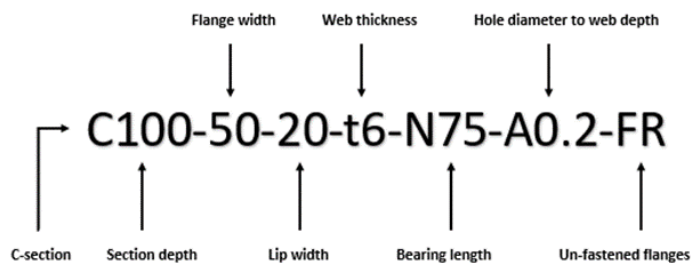
Figure 5. Specimen labelling.